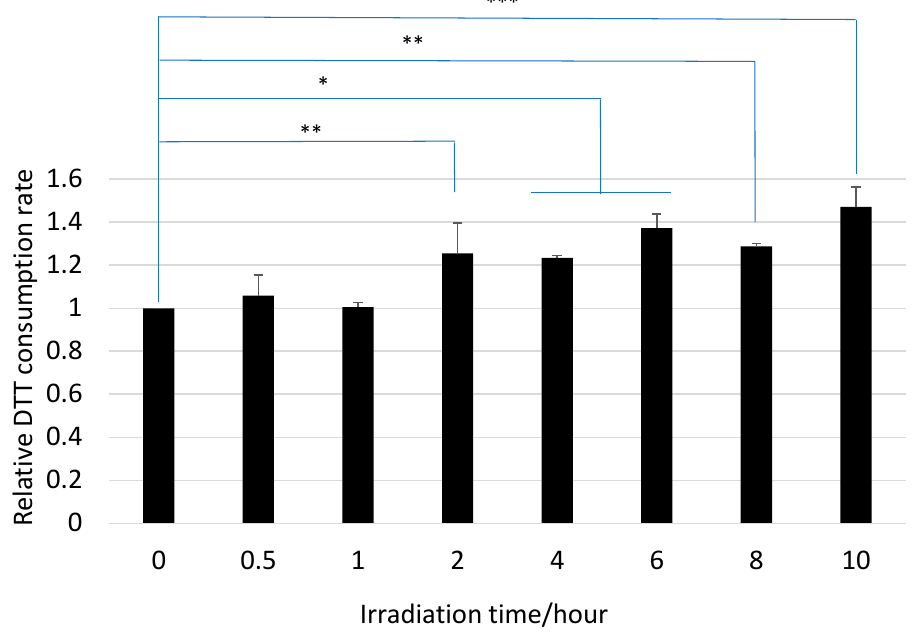
Figure 2. DTT consumption rates of HA before and after UV irradiation (mean ± SD, N = 6; * p < 0.05, ** p < 0.01, *** p < 0.001).